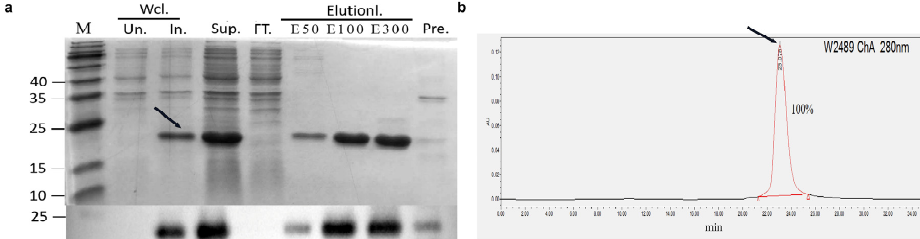
Figure 1. Expression and purification of rhmatIL-33 protein. ( a ) Expression and purification of the rhmatIL-33 protein were checked on western blotting and 15% SDS-polyacrylamide gel electrophore- sis (SDS–PAGE). Aliquots from cell cultures of strain BL21(DE3) grown at 37 ◦ C were taken before and after induction (un and In). Cells were harvested 6 h after induction and disrupted by sonication for 30 min on ice; the expression of rhmatIL-33 in the supernatants and pellets was detected (Sup and Pel). The supernatants were applied to Ni–NTA affinity chromatography and eluted with 50 mM, 100 mM, and 300 mM imidazole, respectively (Lanes E50, E100, E300). Lane FT., Flowthrough; Lane M, molecular weight standards (kDa) ( b ) Analysis of purified rhmatIL-33 by SEC-HPLC. The arrow indicates the position where rhmatIL-33 is